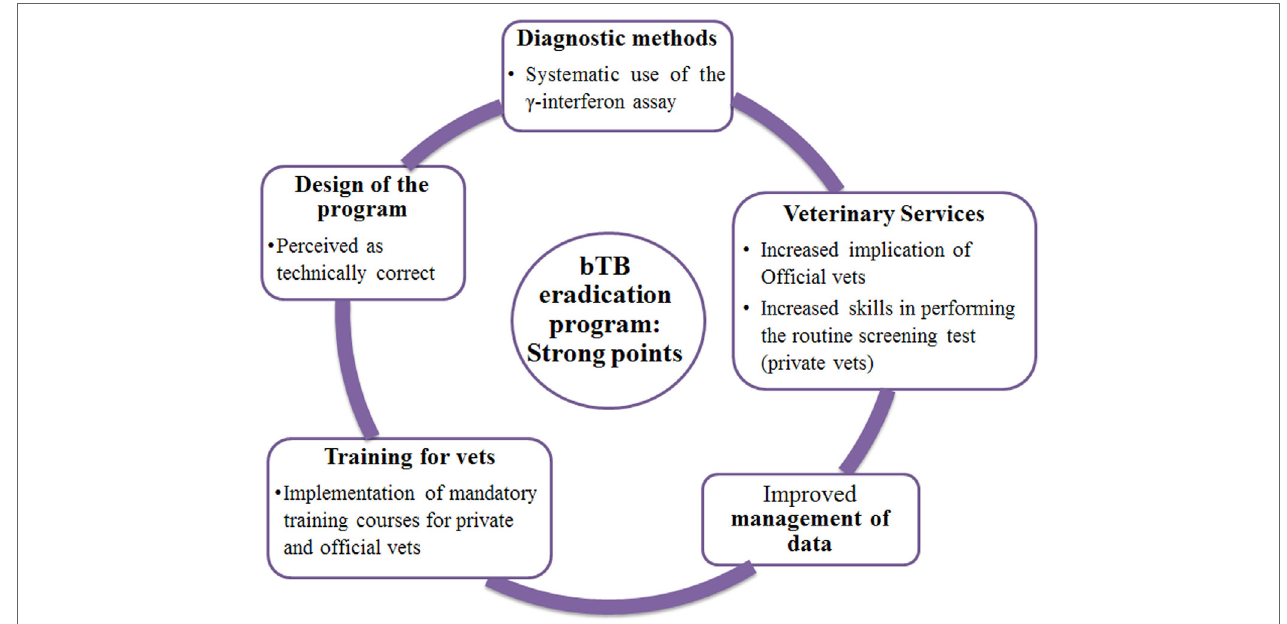
FigUre 2 | Schematic representations of the main themes emerged from exploratory interviews as “Strong points of the bTB eradication program”; results for Andalusia and Catalonia are presented together. “vets” =